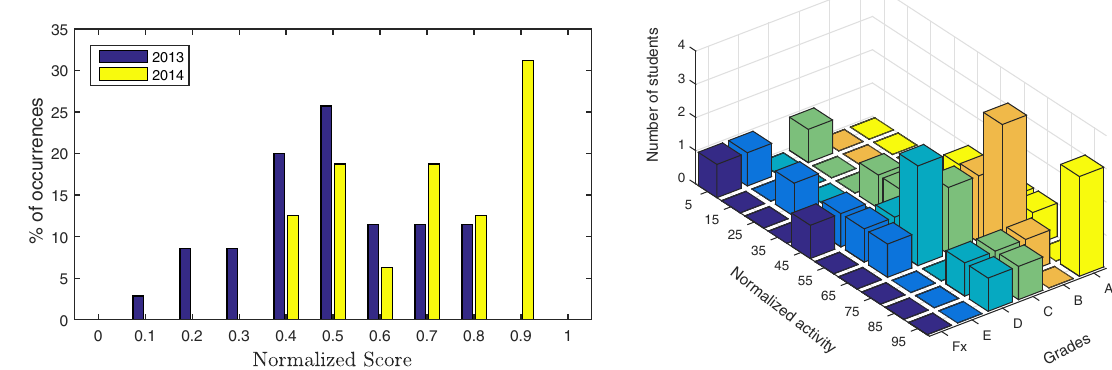
FIG. 3. Left: Results from the midterm test in both 2013 (blue) and 2014 (yellow). In 2013 there was 35 students who answered the midterm test, whereas 17 of the 47 students [35] answered the midterm test in 2014. Right: Histogram of student activity on StudentResearcher vs the grade they received at the oral